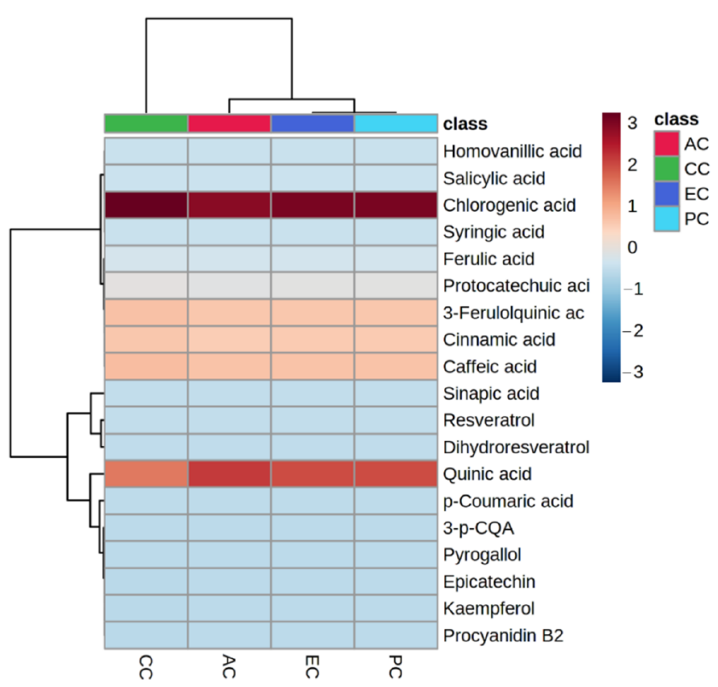
Figure 4. Heatmap clustering of abundant phenolic metabolites in Australian coffee (AC), Colombian